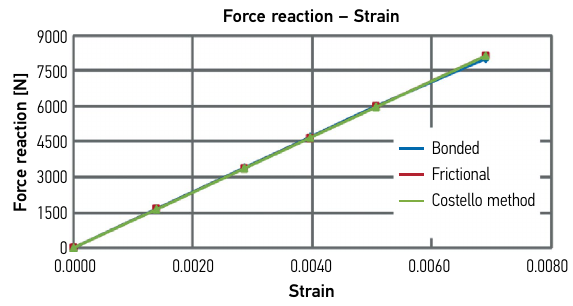
Fig. 11. Diagram of resulting force reaction